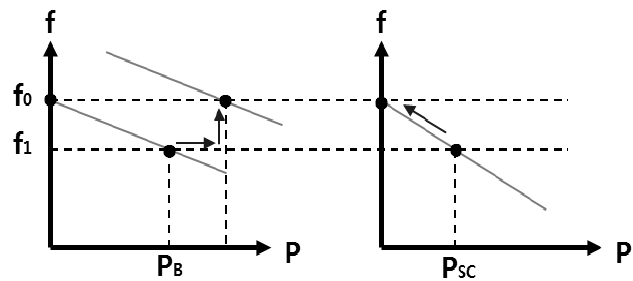
Figure 3. P-f droop curve for Restore Function of